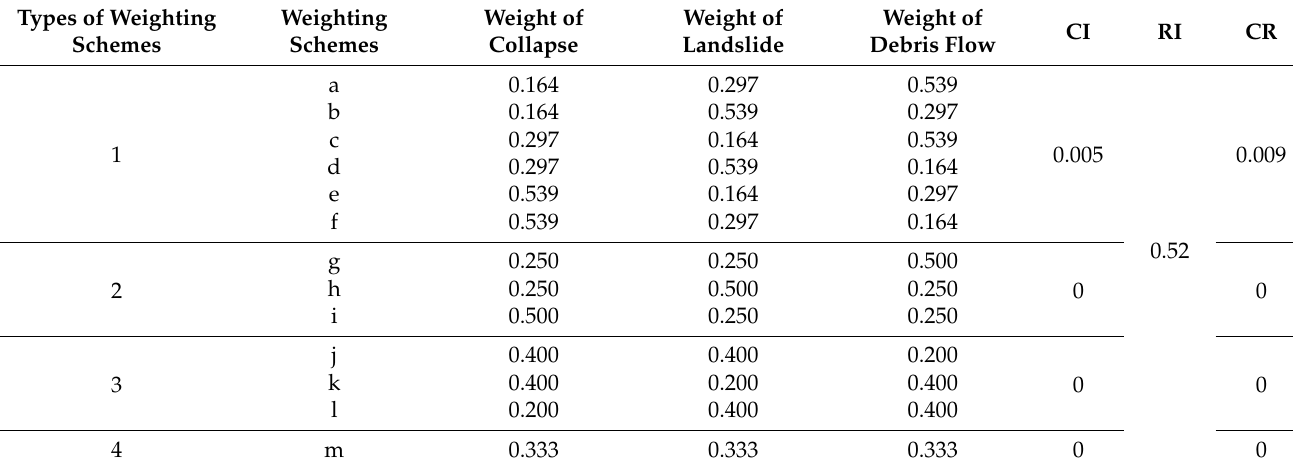
Table 6. The weighting